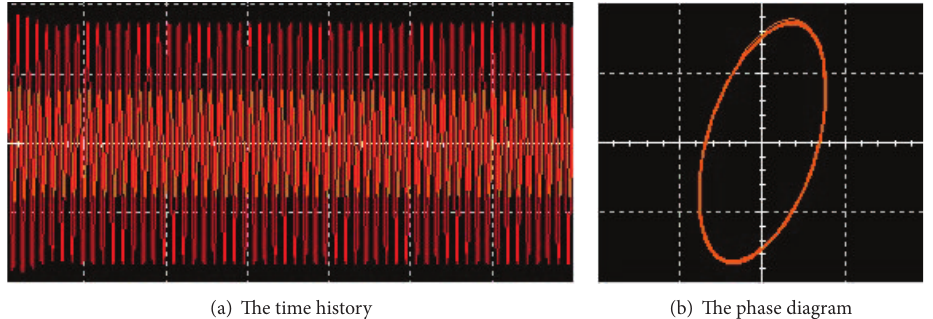
Figure 19: Experimental observations of the time history and phase diagram of system (16) with 𝑎 = 1 , 𝑐 = 0.08 , 𝑚 = 0.5 , 𝑘 1 = 0.8 , 𝑘 2 = 0.5 , and 𝑏 = −0.15